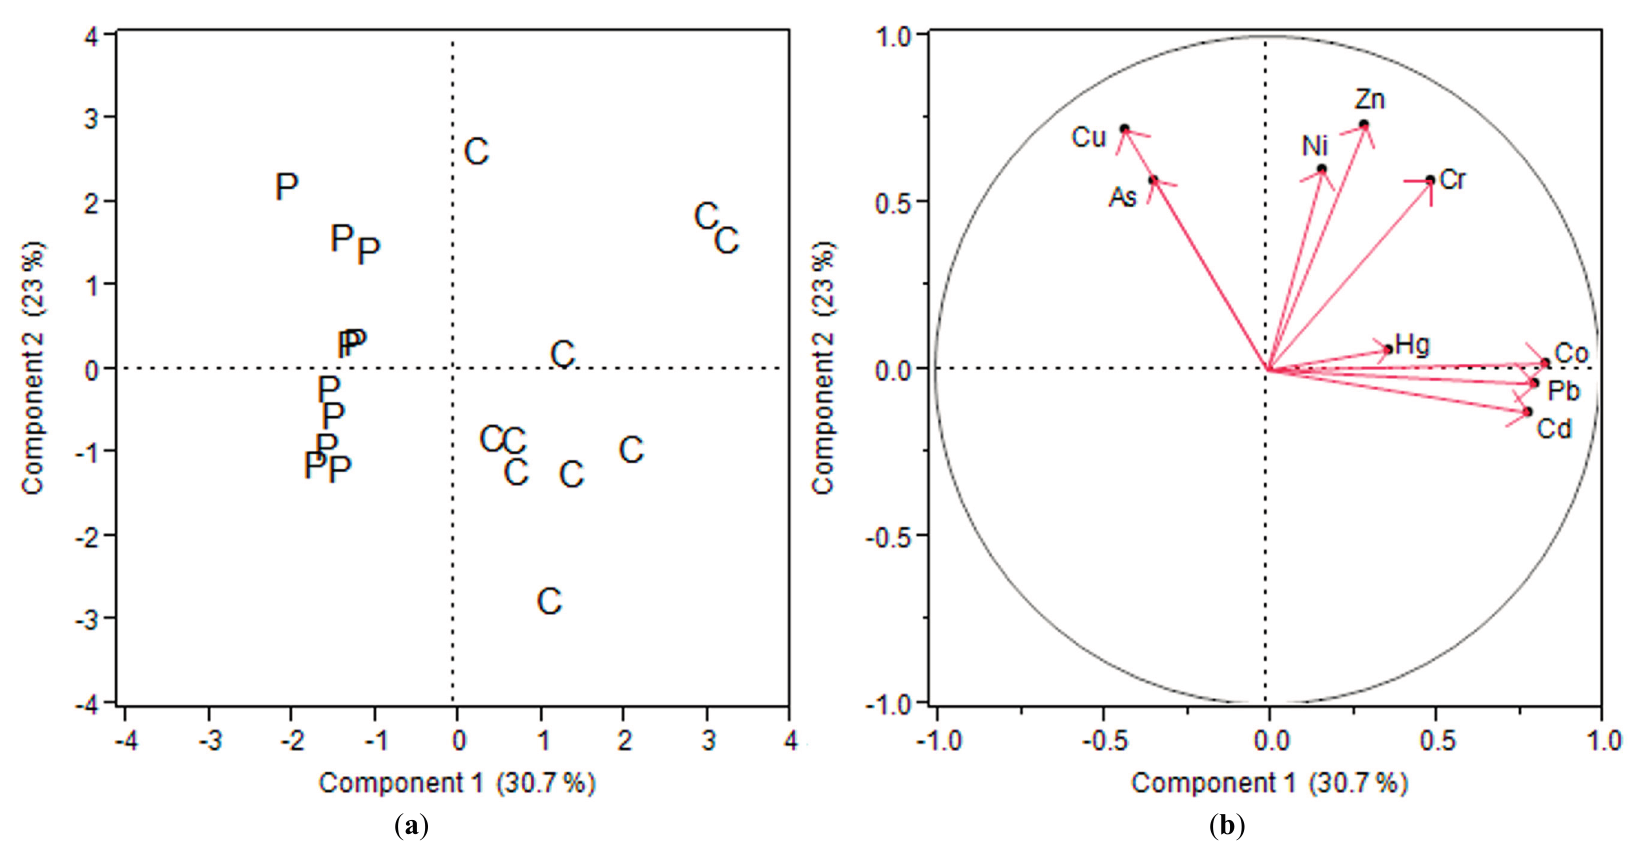
Figure 2. Distribution patterns of metals in foodstuffs characterized by PCA (C: Cassava; P: